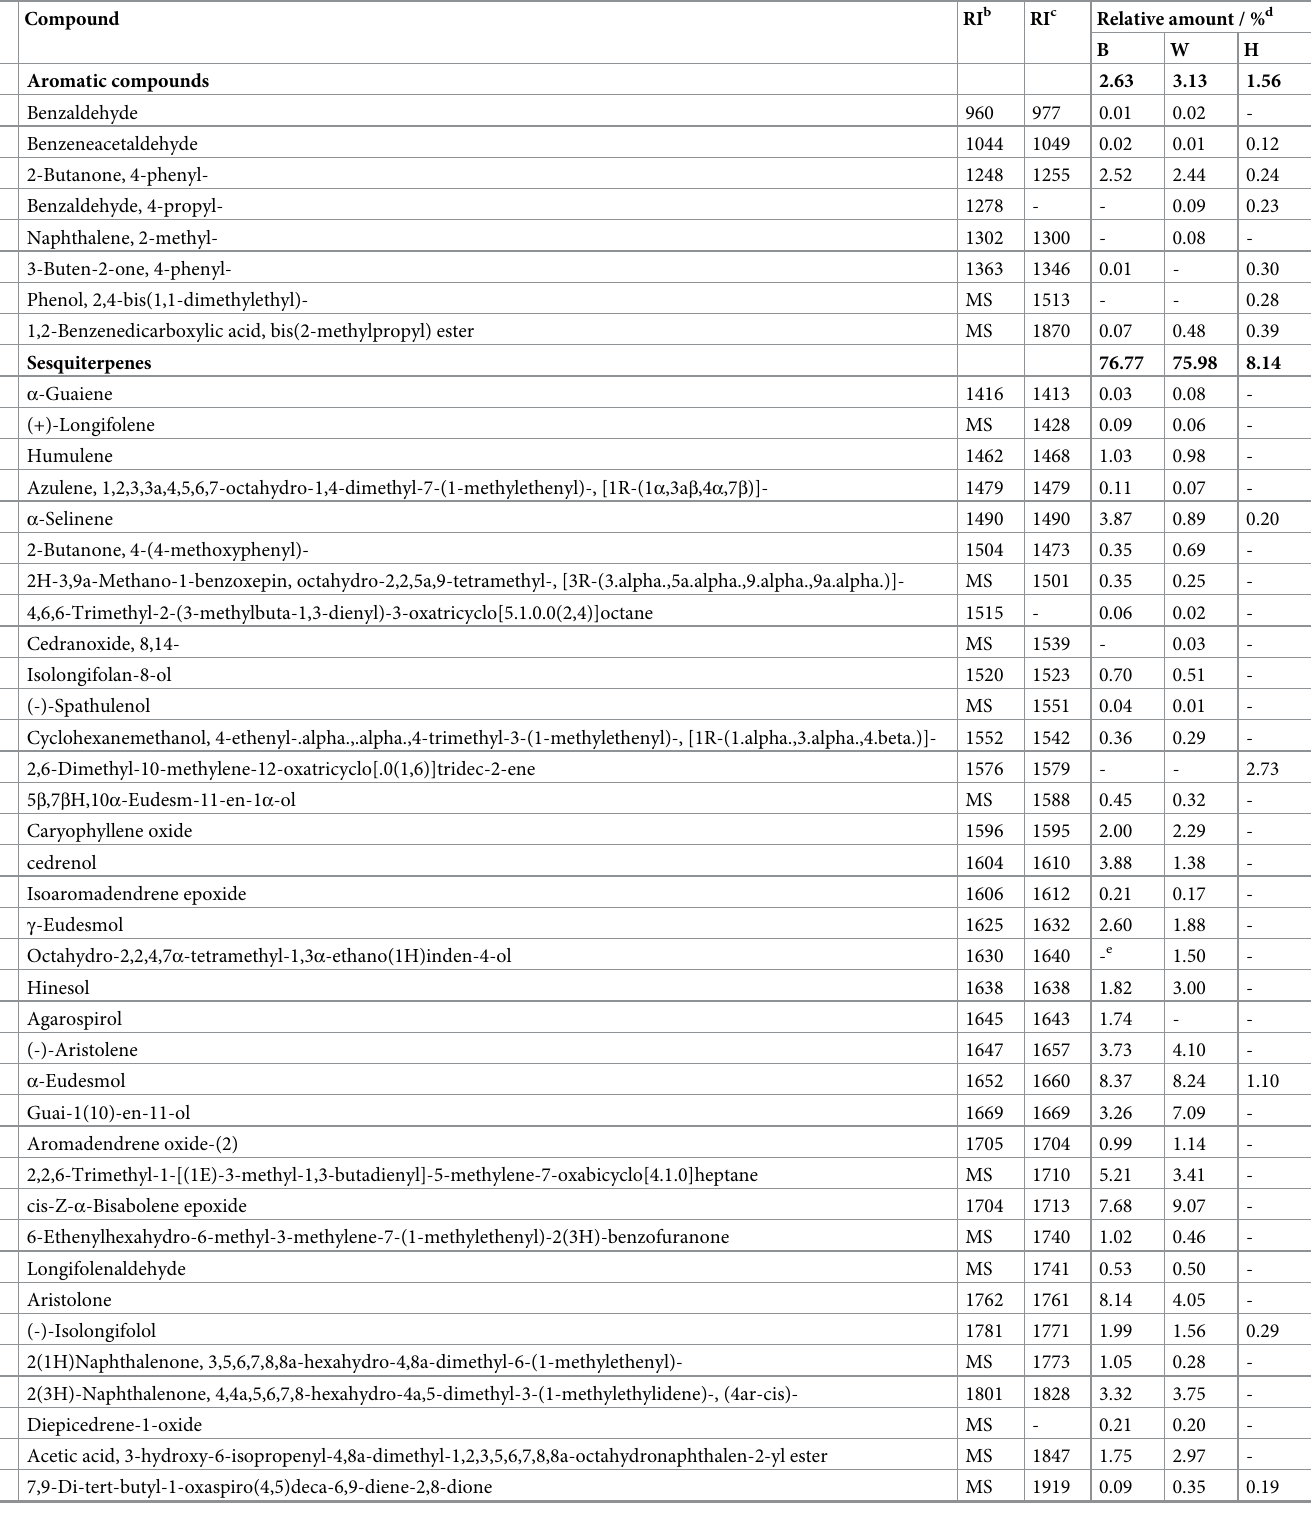
Table 1. Chemical composition and relative amounts of essential oils in the brown zone (B), wild agarwood (W), and healthy zone (H). No. a